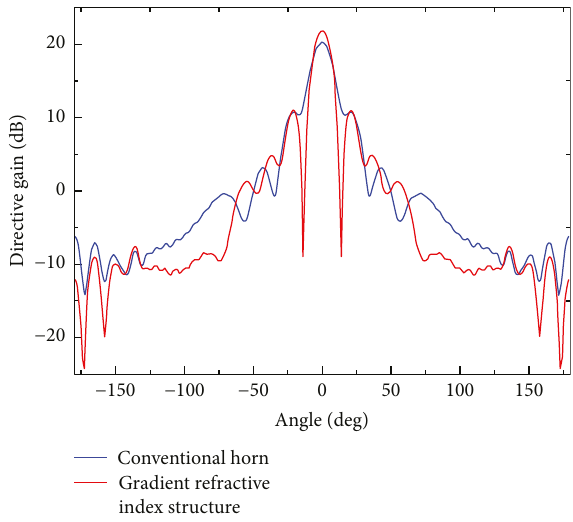
Figure 10: Far- fi eld pattern of the horn antenna with and without the gradient refractive index